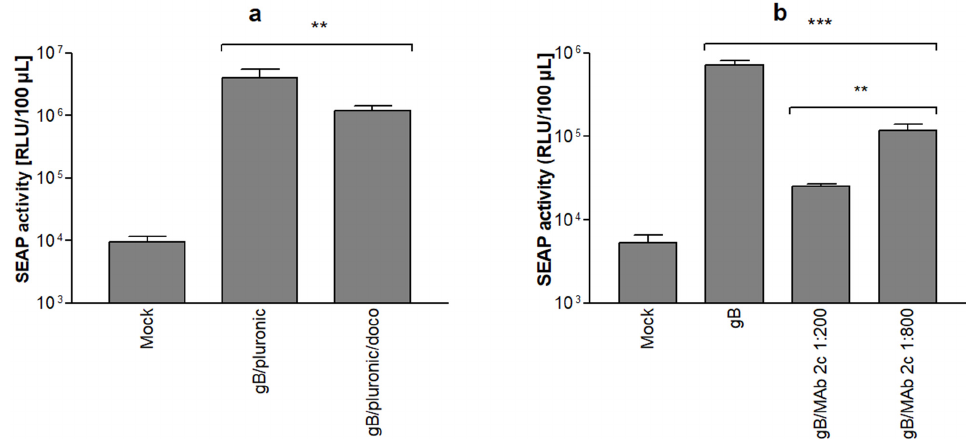
Figure 5. Effect of known inhibitors of HSV-1 glycoprotein-induced membrane fusion on SEAP levels. The inhibitory effect of docosanol is shown in panel ( a ). Reporter cells were treated with either 5 mg/mL docosanol/pluronic or 5 mg/mL pluronic only after transfection as indicated, SEAP levels were determined 48 h post transfection, Mock: empty gB-1 vector backbone. The inhibitory effect of a gB-specific, HSV-neutralizing monoclonal antibody (MAb 2c) is shown in panel ( b ). Reporter cells were treated with different concentrations of monoclonal antibody 2c after transfection as indicated, SEAP levels were determined 48 h post transfection, Mock: empty gB-1 vector backbone, no addition of monoclonal antibody. Data represent means ± SD from quadruplicate, p < 0.01 (**) and p < 0.001 (***).